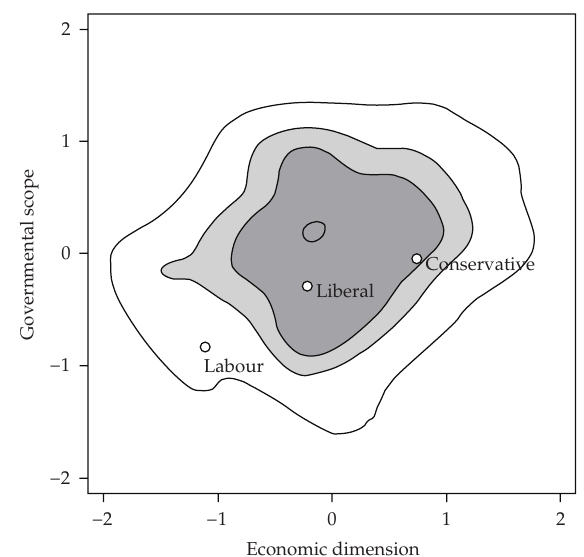
Figure 9: Smoothed electoral distribution in Britain and party positions in 1979.